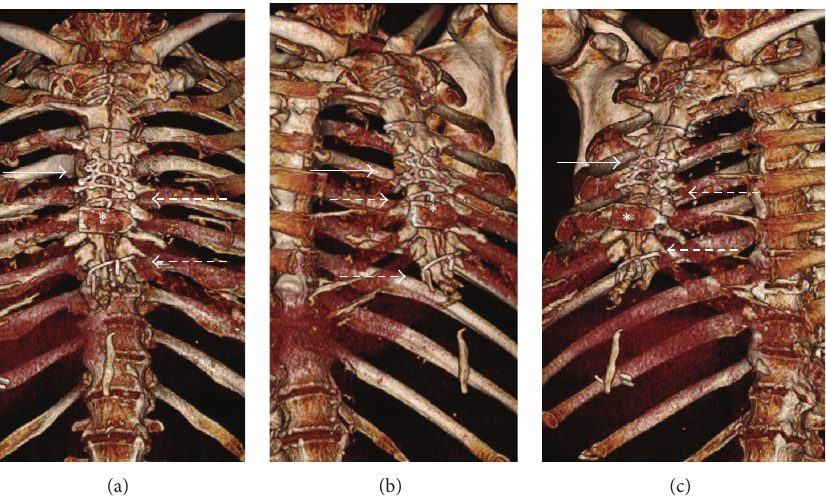
Figure 2: One-month postoperative 3-dimensional computed tomography showing rigid fixation of the “floating” sternum. (a) Anterior- posterior view, (b) right anterior-oblique view, and (c) left anterior-oblique view showing the completed reconstruction. The sternum is intact with appropriate healing. The A-shaped manubrial plate is highlighted by solid arrow , the sternal closure device is highlighted by an asterisk, and the simple sternal wires are highlighted by dashed arrows